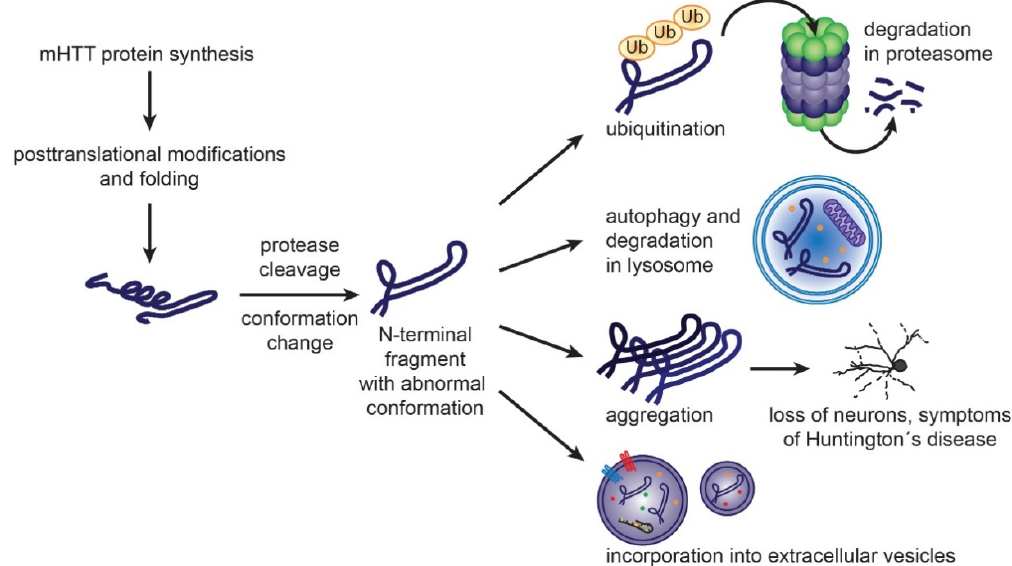
Figure 3. Formation of mHTT toxic species and cellular mechanisms to handle them. Mutant huntingtin protein carrying expanded polyglutamine sequence is prone to adopt abnormal conformation. Post translational modifications and protease cleavage may contribute to formation of misfolded N-terminal fragments. Molecular chaperones, such as Heat Shock Proteins, participate in re-folding of misfolded proteins. Once unsuccessful, the resulting misfolded proteins can be degraded by ubiquitin-proteasome system or autophagy. Accumulation of misfolded mHTT rich in β -sheet structure leads to aggregate formation, loss of neurons and Huntington’s disease symptoms. Misfolded proteins may be eliminated from neurons also by exosomal secretion [86–88].